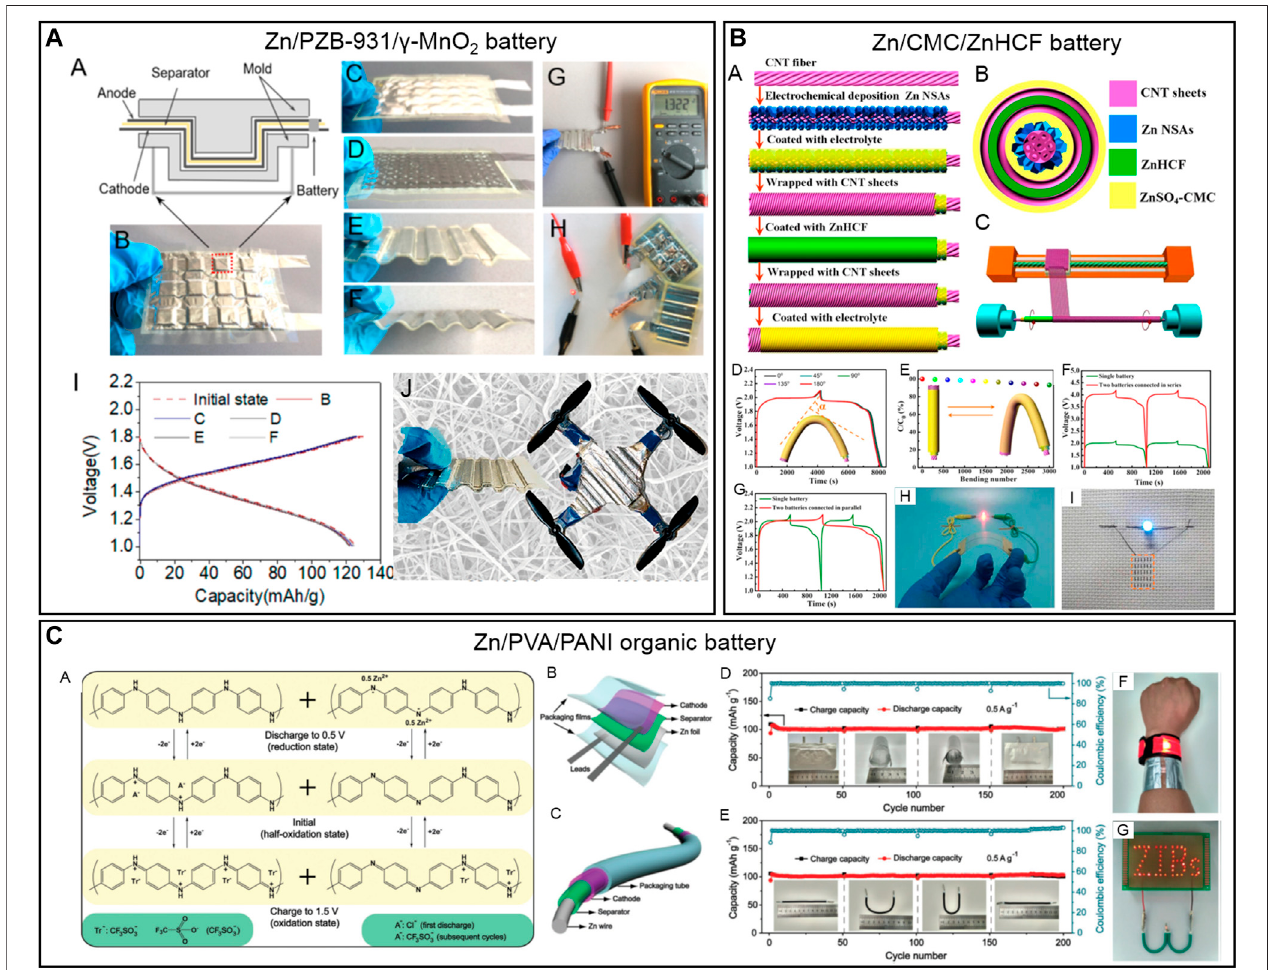
FIGURE 1 | (A) Schematics and pictures of different plastically deformed Zn/PZB-931/ γ -MnO 2 SSZIBs, their galvanostatic charge and discharge curves at 0.2 ° C, andadronepoweredbytheZn/PZB-931/ γ